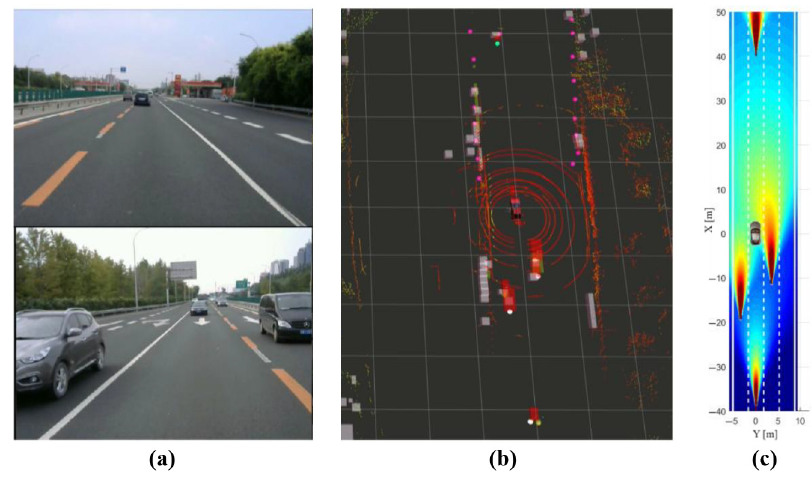
Figure 14 The continuously overtaking